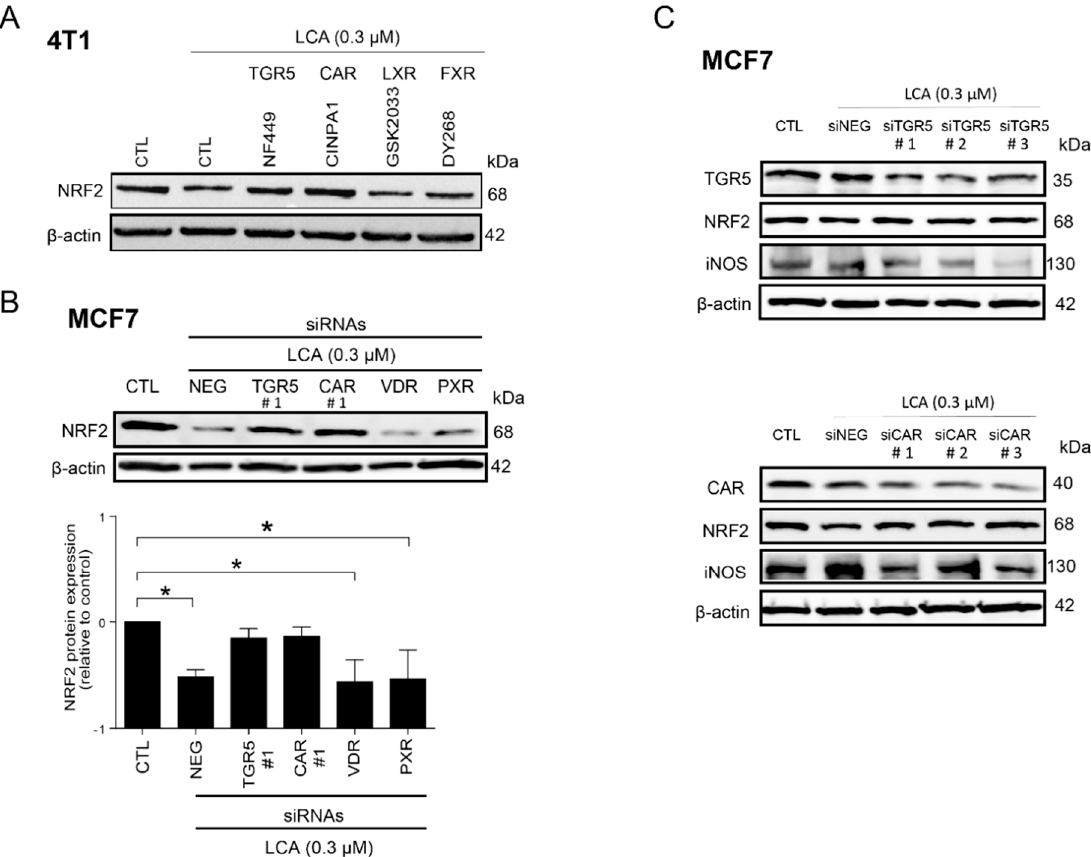
Figure 9. LCA-induced oxidative stress responses were mediated by TGR5 and by CAR receptors. ( A ) The 4T1 cells were treated with 0.3 µm LCA and NF449, CINPA1, DY268, or GSK2033 at a final concentration of 5 µm for 48 h, then NRF2 protein expression was detected using western blotting (representative figure, n = 2). ( B , C ) TGR5, CAR, VDR, and PXR bile acid receptors were silenced in MCF7 cells by transiently transfecting the cells with the corresponding siRNA or a negative control siRNA. After 48 h, protein expressions of ( B , C ) NRF2 and ( C ) iNOS were determined by western blotting ( n = 3). Data are plotted as mean ± SEM. * p < 0.05, control vs. LCA / siRNA treated. (CAR, constitutive androstane receptor; FXR, farnesoid X-activated receptor; LCA, lithocholic acid; LXR, liver X nuclear receptor; NRF2, nuclear factor, erythroid 2-like 2; TGR5 / GPBAR1, G protein-coupled bile acid receptor 1 / Takeda G-protein coupled receptor; VDR, vitamin D receptor).